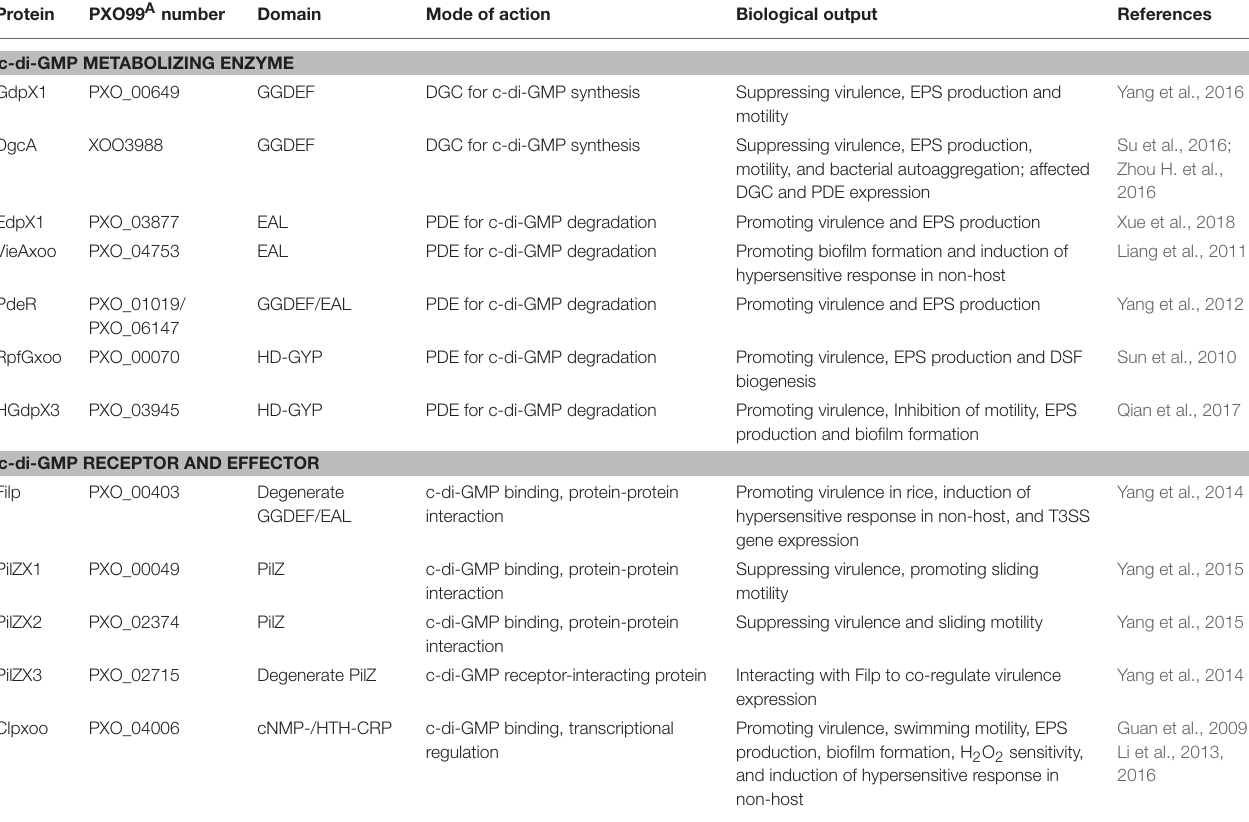
TABLE 1 | Identification of c-di-GMP metabolizing enzymes, receptors, and effectors in Xanthomonas oryzae pv. Oryzae .